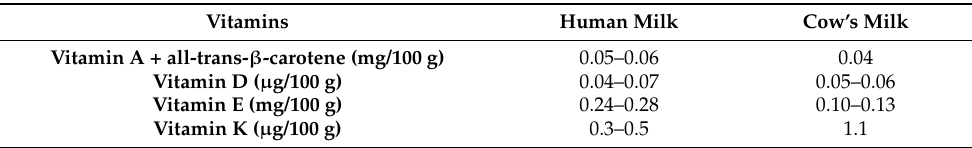
Table 5. Content of lipophilic vitamins in human and cow milk. Data from Baldi and Pinotti (2008) [9],